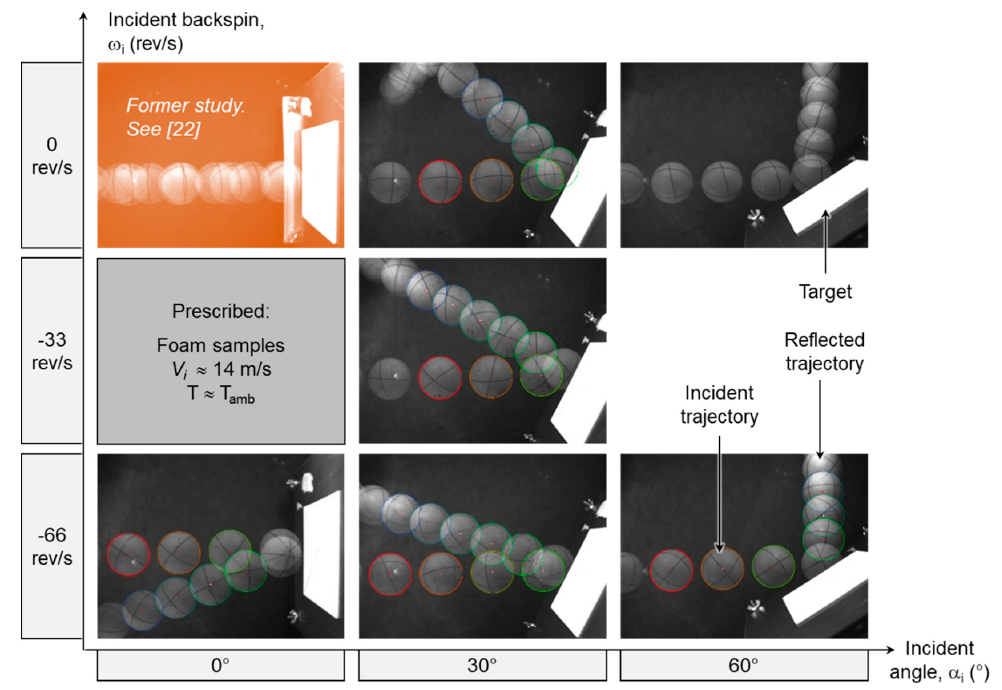
Figure 4. Raw images of the various impact tests performed on the foam